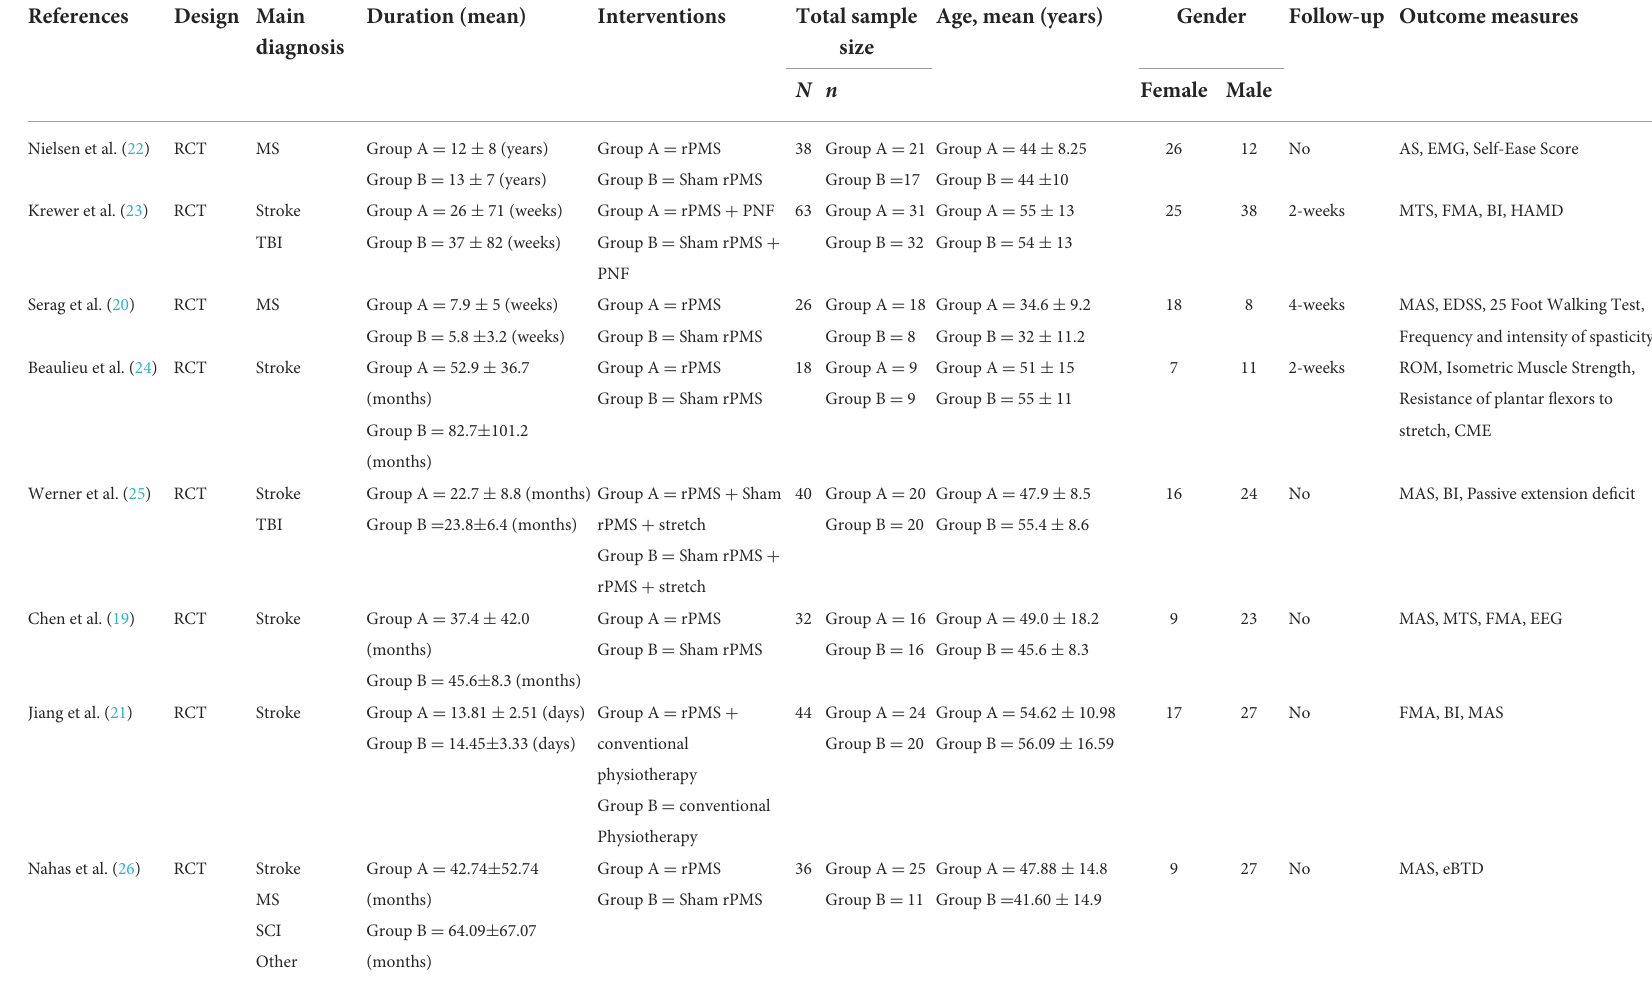
TABLE 1 Characteristics of included studies in this conducted systematic